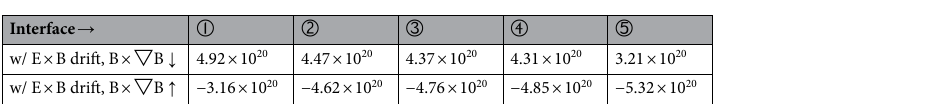
Figure 6. The divertor particle and heat fluxes at the inner and outer targets for case without drifts and cases with only E × B drift.